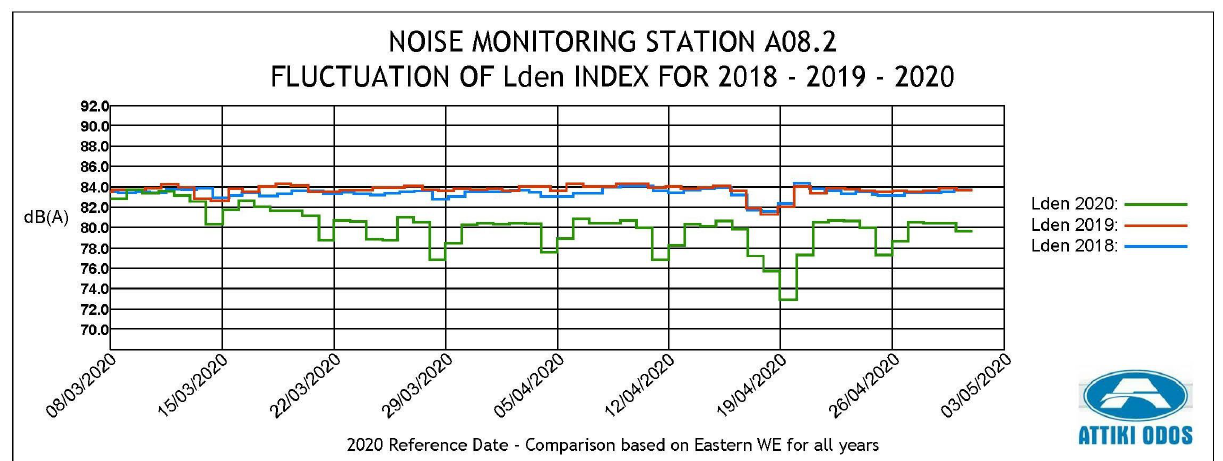
Figure 9c: Fluctuation of L den index – Noise monitoring station